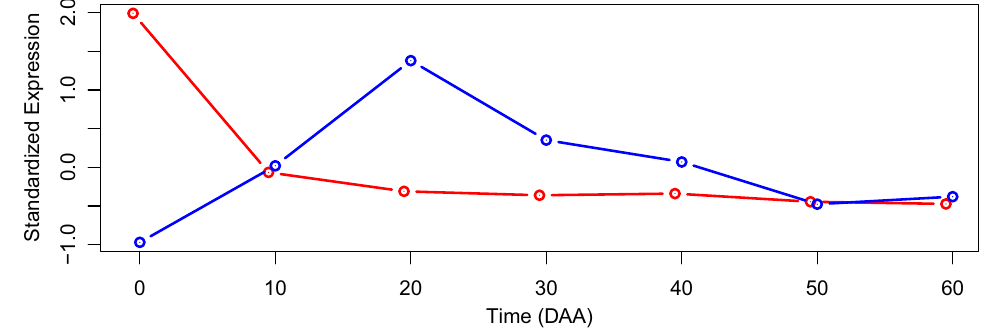
Figure 3. Raw plot resulting of running the function “ SEPs.plot(list(temp1, temp2), colors = c(”red”, ”blue”)) ”. The input (objects “ temp1 ” and “ temp1 ”) are sets of SEPs containing MYB transcription factors expressed in the accession “CM” at times 0 and 20 DAA,